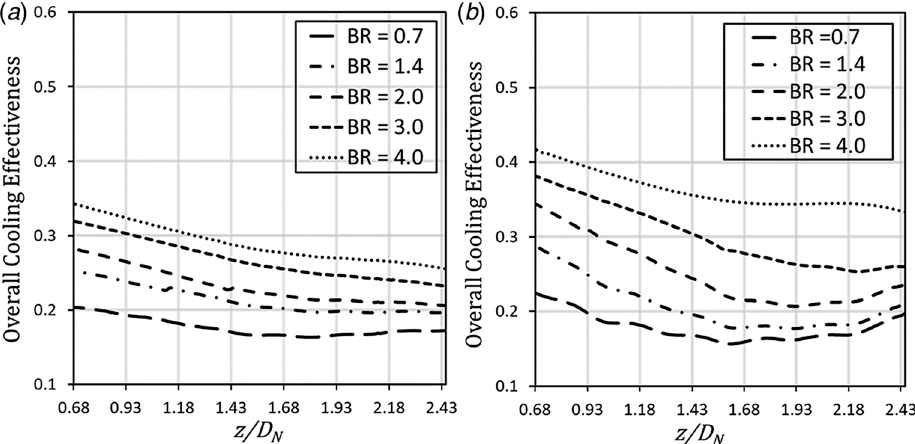
Figure 10. Lateral-averaged overall effusion cooling efficiency of the combustor liner: ( a ) inline arrangement and ( b ) staggered arrangement. Reprinted with permission from [84]. Copyright 2021 ASME.